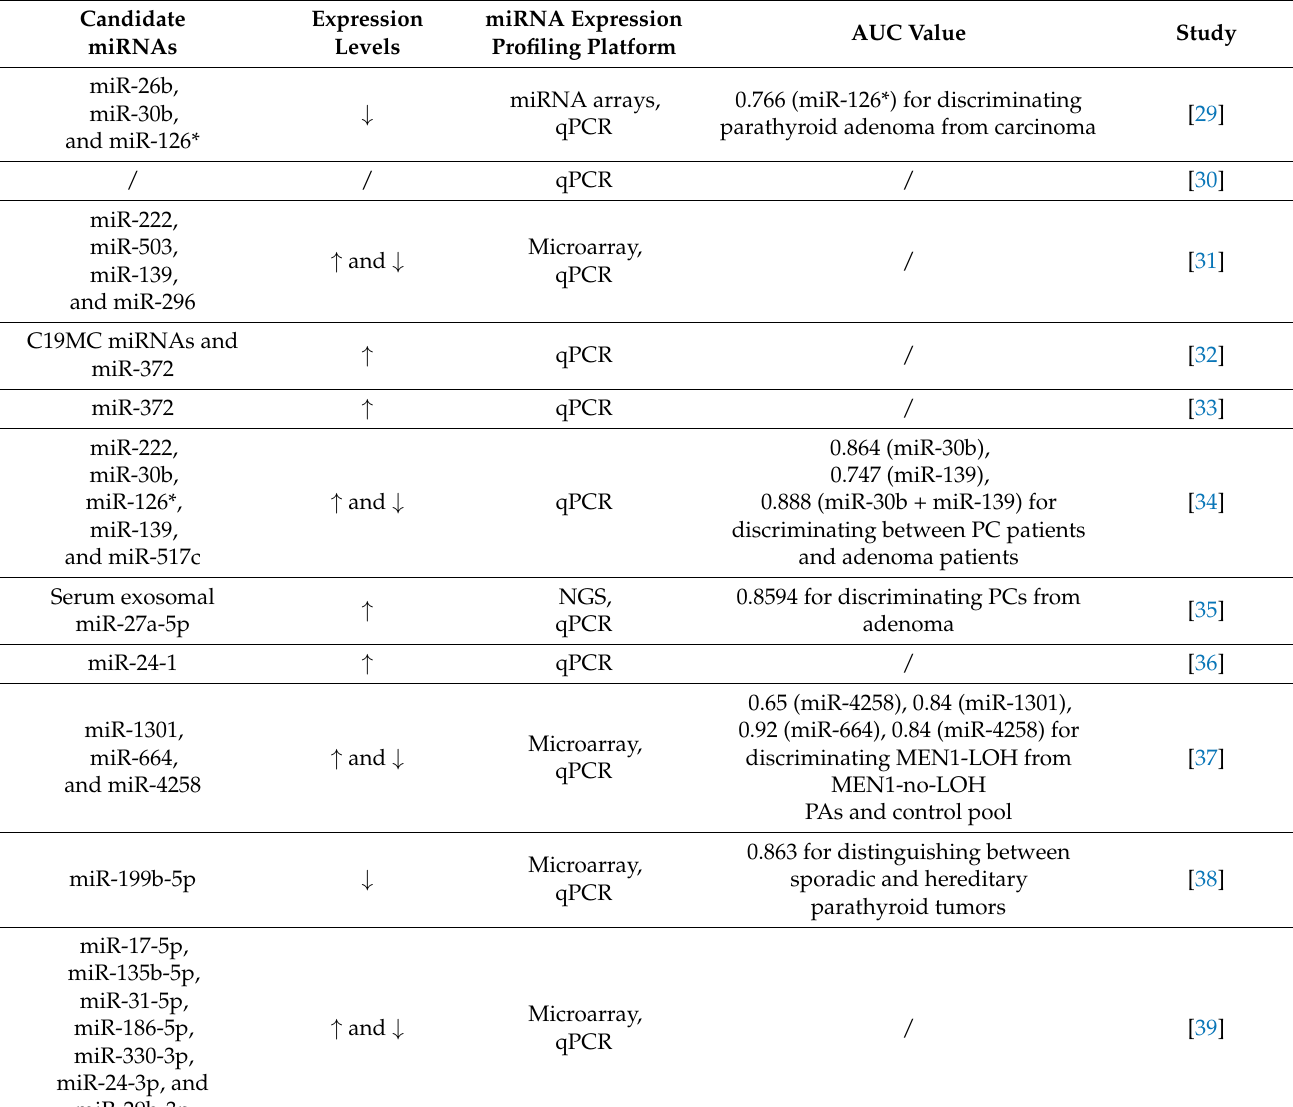
Table 1. Summary of differentially expressed miRNAs in parathyroid